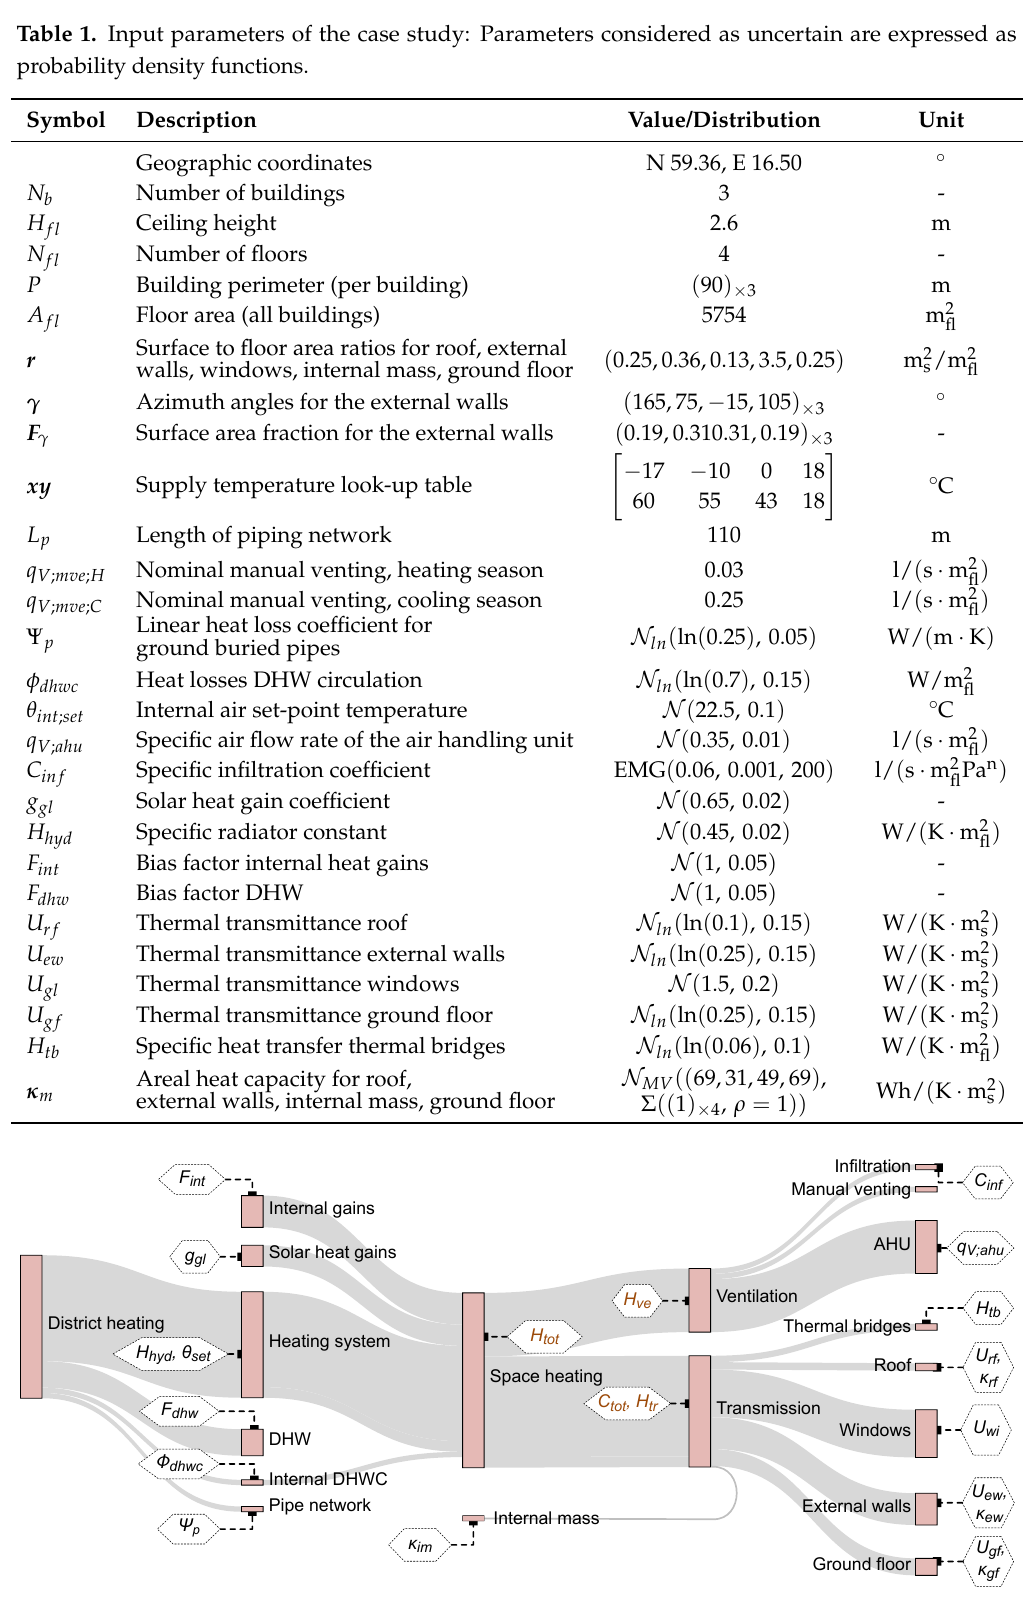
Figure 8. Parameters selected as uncertain, placed at the energy flow they influence: Brown colored names show parameters that are calculated from lower levels and, thus, not explicitly given prior probability densities. Height of the gray areas indicates relative share of the yearly heat flow, based on the prior